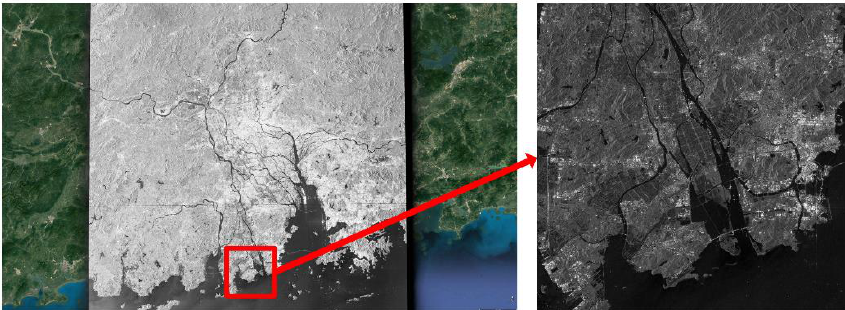
Figure 7. The selected training area from the first Sentinel-1 SAR image.